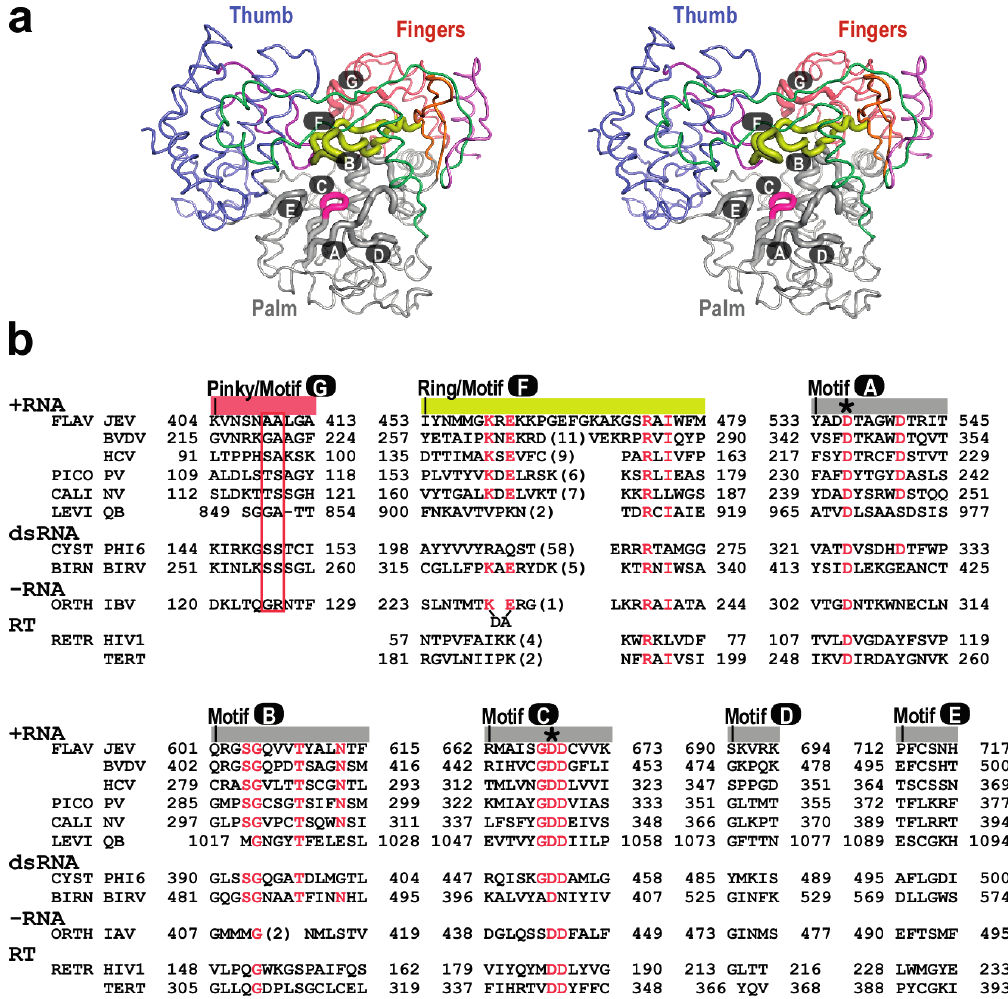
Figure 2. Catalytic motifs of Flaviviridae RdRPs. ( a ) Stereo-pair images of spatial organization of the JEV RdRP catalytic motifs A–G (pdb entry: 4K6M). Seven RdRP motifs are shown as thick noodles. The color-coding is as in Figure 1b; ( b ) A structure-based sequence alignment depicting the conservation of RdRP motifs (pdb entries: 4K6M, 1S4F, 1NB4, 3OL6, 3BSO, 3AVT [36], 1HI0, 2PGG [37], 4WRT [38], 1RTD [39], and 3DU6 [40]). Three RdRPs from other positive-strand RNA viruses (PICO/PV: Picornaviridae /poliovirus; CALI/NV: Caliciviridae /norovirus; LEVI/QB: Leviviridae /bacteriophage Q β ), two from double-stranded RNA viruses (CYST/PHI6: Cystoviridae /bacteriophage ϕ 6; BIRN/BIRV: Birnaviridae /birnavirus), one from negative-stranded RNA viruses (ORTH/IBV: Orthomyxoviridae /influenza virus B), and two reverse transcriptases (RTs) (RETR/HIV1: Retroviridae /human immunodeficiency virus 1; TERT: Telomerase RT) were chosen as representatives for alignment and/or comparison. Only the structurally conserved segment of motif D is included in this alignment. Some important RdRP consensus residues are highlighted in red. Two motif G residues interacting with the +1/+2 junction of the RNA template are indicated by a red box. The two universal aspartic acid residues are indicated by asterisks. Numbers in parenthesis indicate the number of residues not shown. The alignment of IBV polymerase motif G is of lower confidence due to a lower level of structural similarity to motif G in other